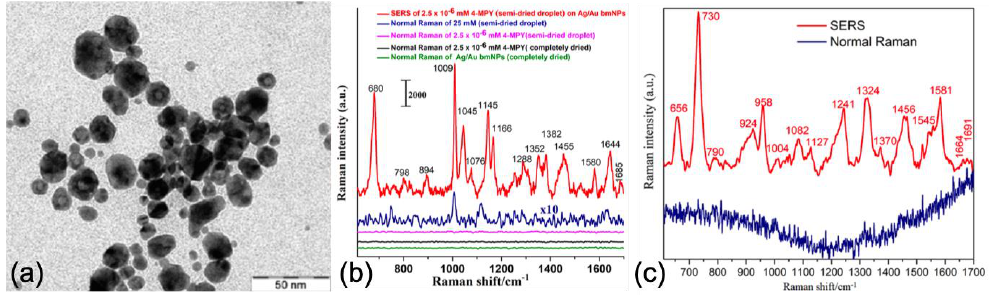
Figure 4. ( a ) TEM image of Au/Ag nanoparticles. ( b ) SERS spectrum of 4-MPY molecules at 2.5 nM concentration (in red). ( c ) SERS spectrum of Escherichia coli . All the figures are reprinted (adapted) with permission from [85], Copyright 2020 American Chemical